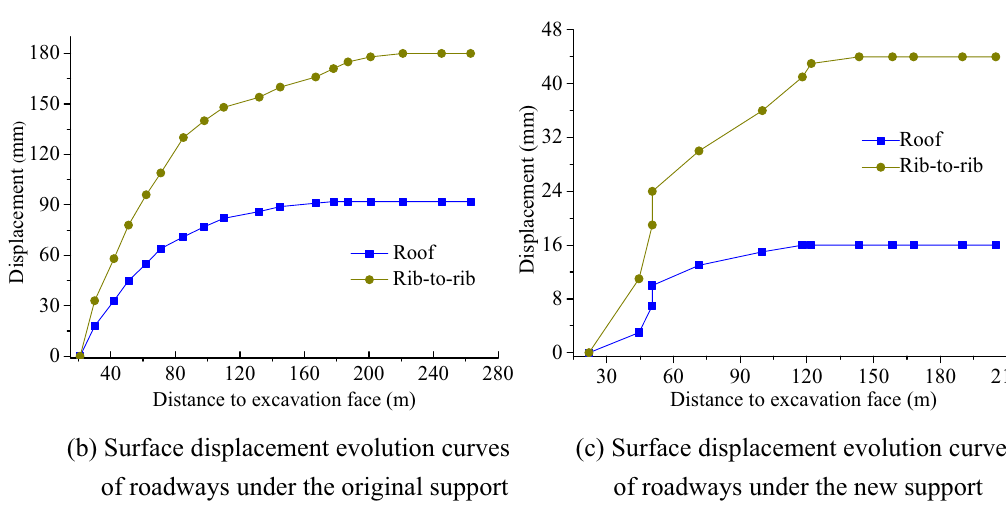
Figure 23. Monitoring data under the original support and the new